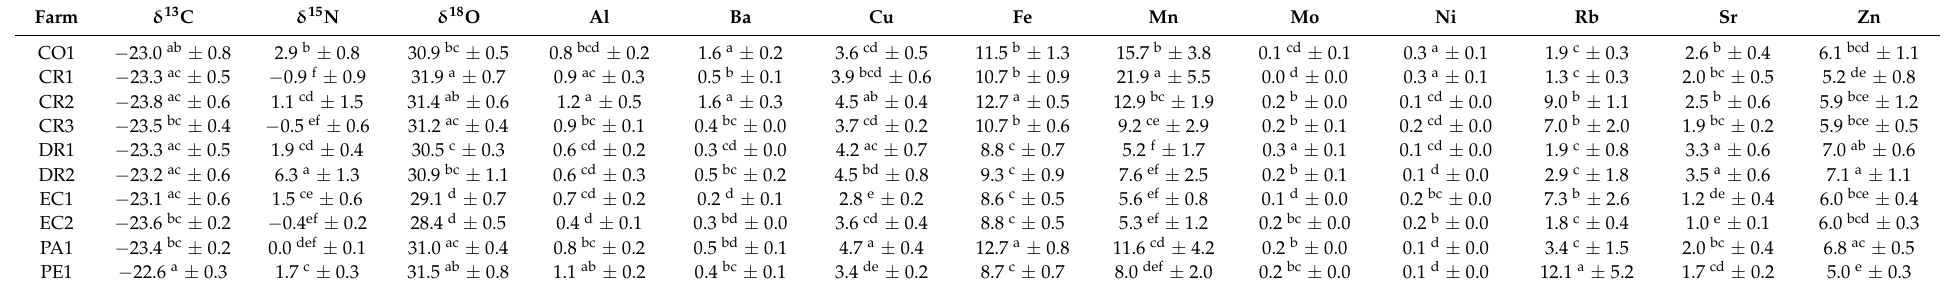
Table 2. The analysis of variance (ANOVA) of the stable isotopes ratios ( 13 C/ 12 C, 15 N/ 14 N and 18 O/ 16 O) and elemental compositions (mg/kg) of banana pulp samples ( n = 12). Farm